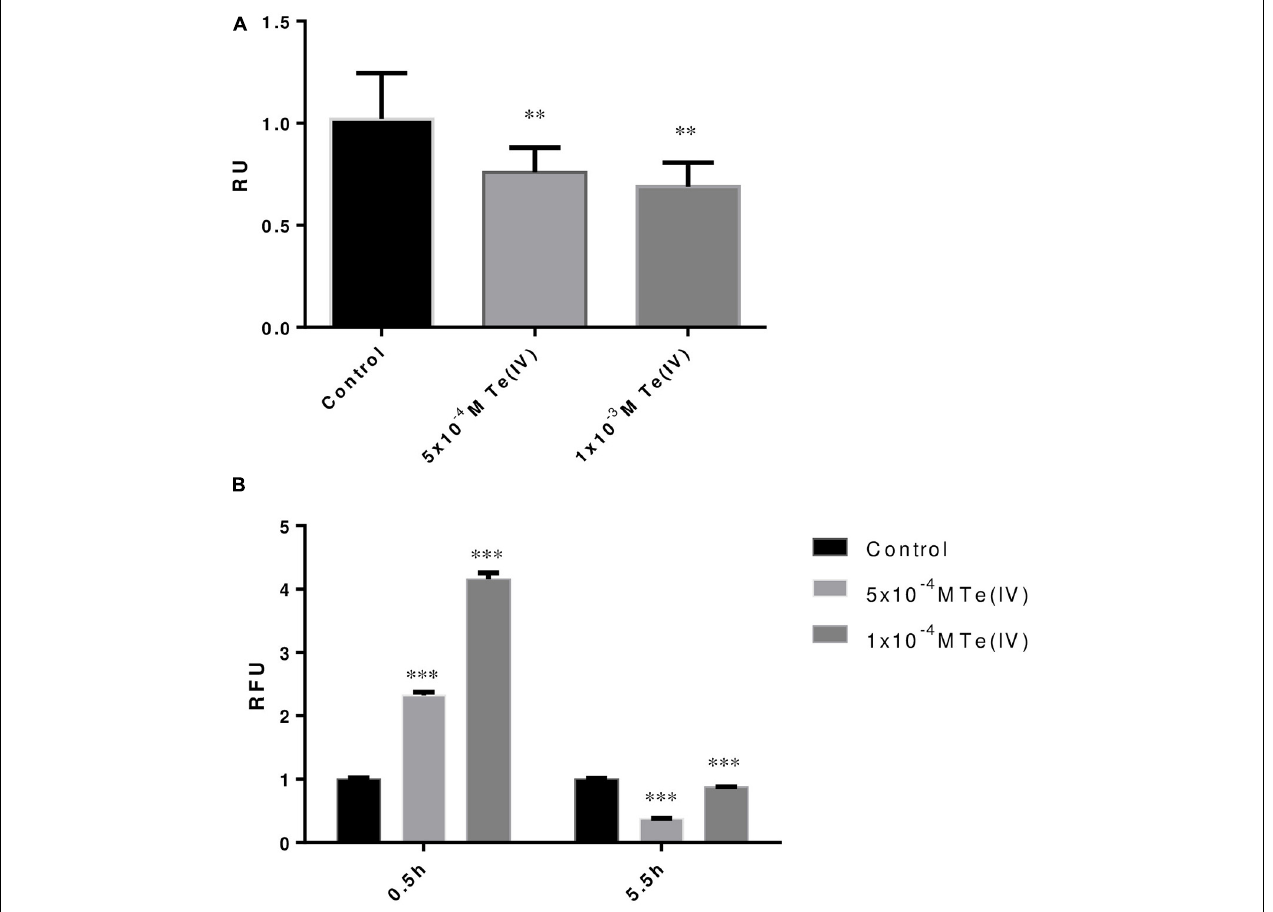
FIGURE 2 | Tellurite-induced stress response of Paenibacillus pabuli ALJ109b. (A) MTT assay of strain P. pabuli ALJ109b. Relative units (RU) represent the ratio between the absorbance (MTT) of each treatment compared to control (without metal). (B) ROS assays showing two incubation periods with H 2 DCFDA. Relative fluorescence units (RFU) represent the ratio between the fluorescence intensity (ROS) of each treatment compared to control (without metal). Data shown are the mean values ( ± standard deviations) obtained from three independent experiments. Significant difference of values from treatment from the value of Control computed by one-way ANOVA ∗∗ p ≤ 0.01, ∗∗∗ p ≤